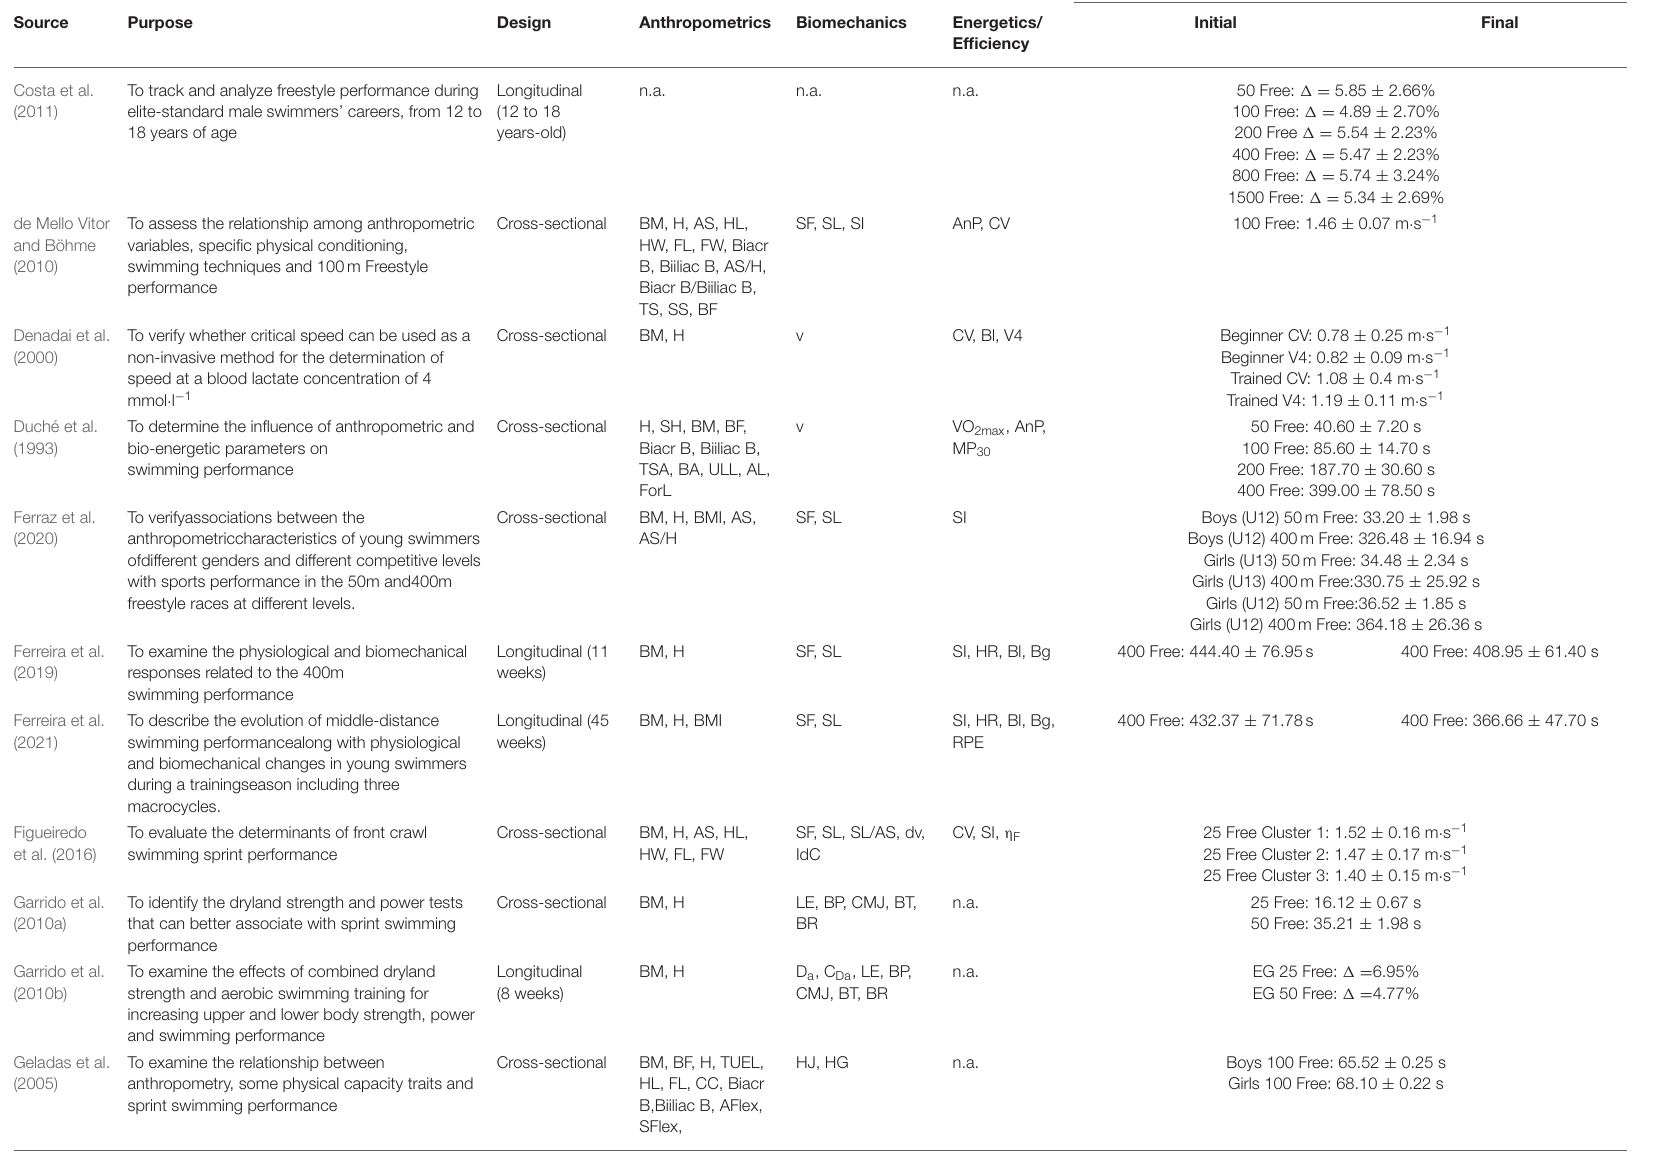
To track and analyze freestyle performance during elite-standard male swimmers’ careers, from 12 to